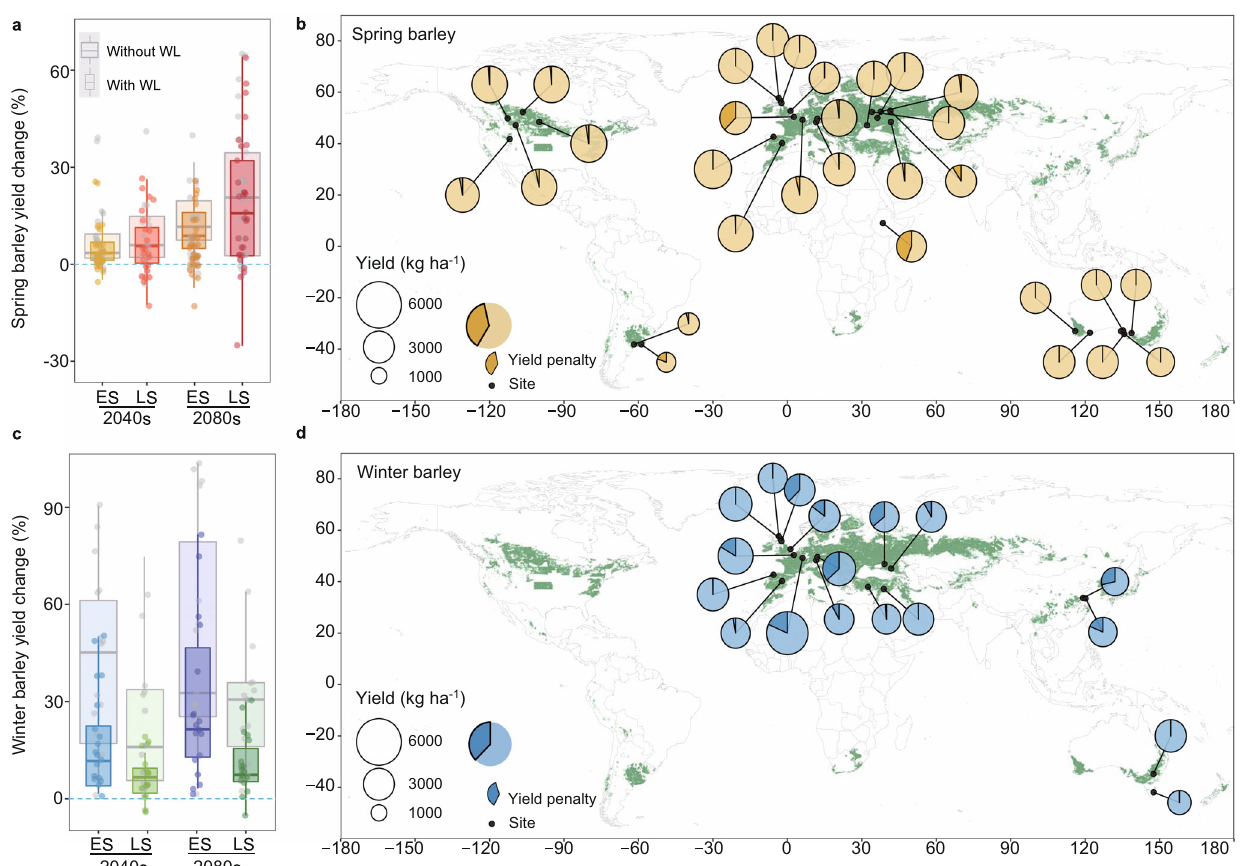
Fig. 2 | Impacts of waterlogging on yield under future climates (2040, 2080) relativetothehistoricalbaseline(1985 – 2016)forearlyandlatesowing(ES,LS). a , c Simulated yield differences under future climates with and without water- logging (WL) for genotypes with early (spring sowing barley) or late maturity (autumn/winter sowing barley). b , d Simulated yields (pie charts; dark segments denote yield penalty) under late sowing for spring barley and early sowing for winter barley in 2040 (results for early or late sowing in 2040 and 2080 can be